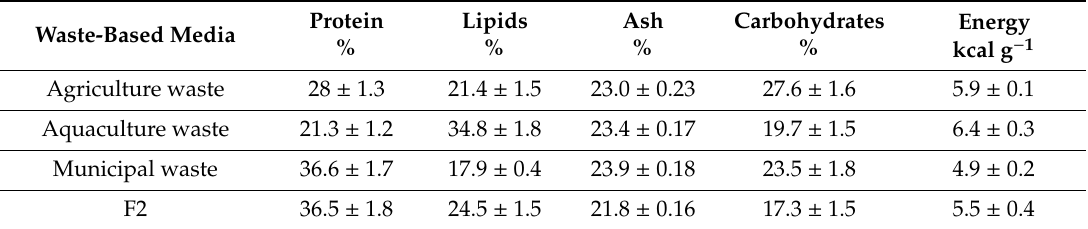
Table 4. Biochemical composition of Nannochloropsis oceanica grown on three waste based formulated media and on F2 (presented per dry